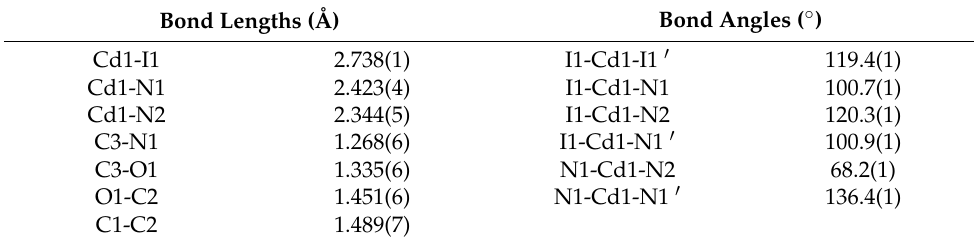
Table 6. Selected bond lengths (Å) and angles ( ◦ ) for complex [CdI 2 (L (cid:48) H 2 )] ( 5 ) a . Bond Lengths (Å)